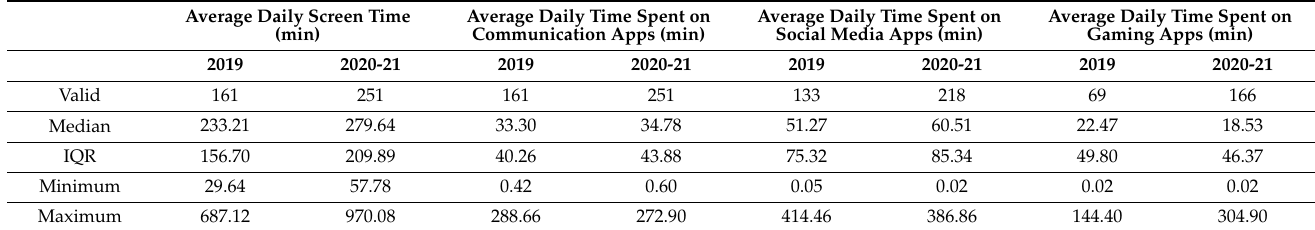
Table 1. A summary of the daily time spent on smartphones in 2019 and 2020-21.